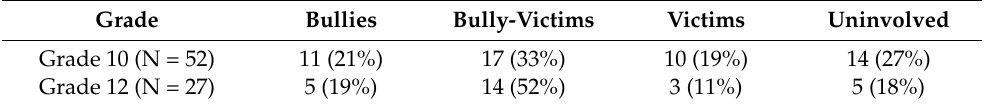
Table 5. Cyberbullying roles.